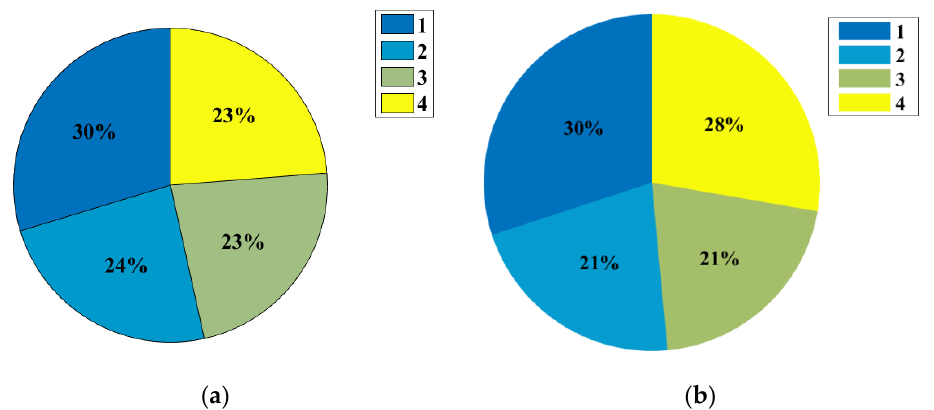
Figure 3. Number of tomatoes in the training set and test set. ( a ) Training set; ( b ) test set. The figures in the legend represent 1: <60%, 2: 61%_70%, 3: 71%_80%, 4: 81%_100% of the maturity of the four grades of tomato in the percentage of the data set.